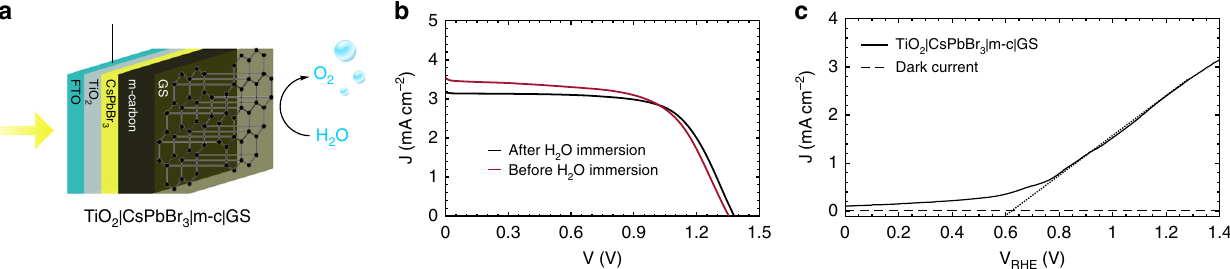
Fig. 2 TiO 2 |CsPbBr 3 |m-c|GS as solar cell and photoanode. a Schematic illustration of the CsPbBr 3 photoanode for PEC O 2 evolution: TiO 2 |CsPbBr 3 |m-c|GS uses commercial conductive GS on the m-carbon layer; The photoanode is illuminated through the FTO glass. b Photovoltaic current density-voltage curves measured under simulated AM 1.5 G solar light (100 mW cm − 2 ) before and after 2 h of immersion in water. Curves shown are measured in reverse scan. c Typical linear sweep voltammetry (LSV) measured under PEC conditions at a scan rate of 20 mV s − 1 , measured in 0.1 M KNO 3 at pH 4.3, under continuous simulated AM 1.5 G solar illumination, 1